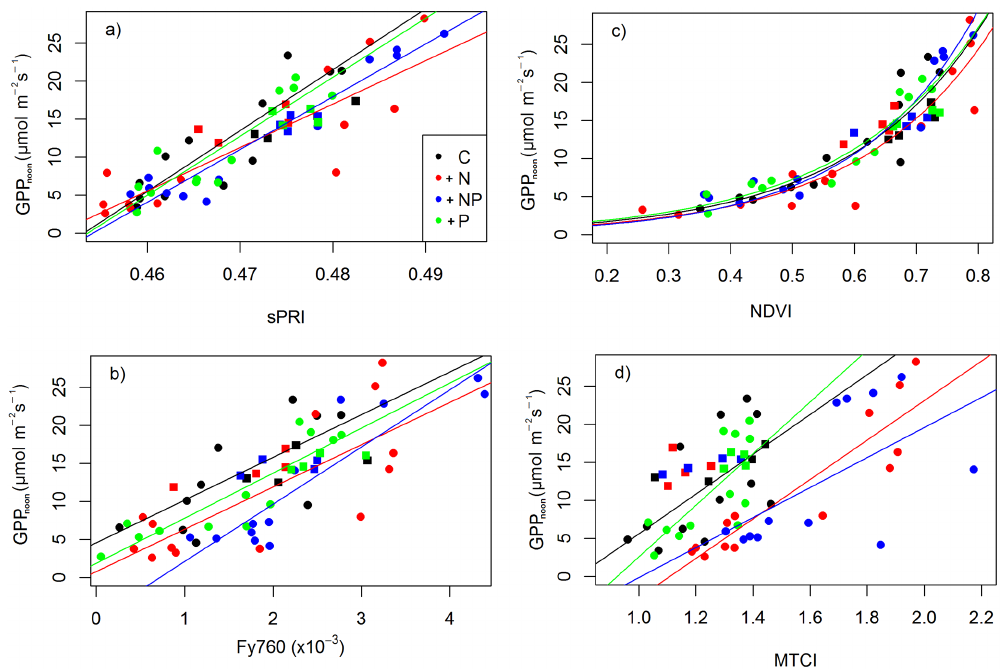
Figure 4. Relationship between GPP noon and remote-sensing data: (a) scaled photochemical reflectance index (sPRI), (b) apparent fluo- rescence yield, (c) normalized difference vegetation index (NDVI), and (d) MTCI. Square symbols represent measurements taken in the pretreatment (no. 1) and circles after fertilization (nos. 2–4). Data were obtained at midday and lines represent results from the regressions for each treatment excluding measurements in the pretreatment.